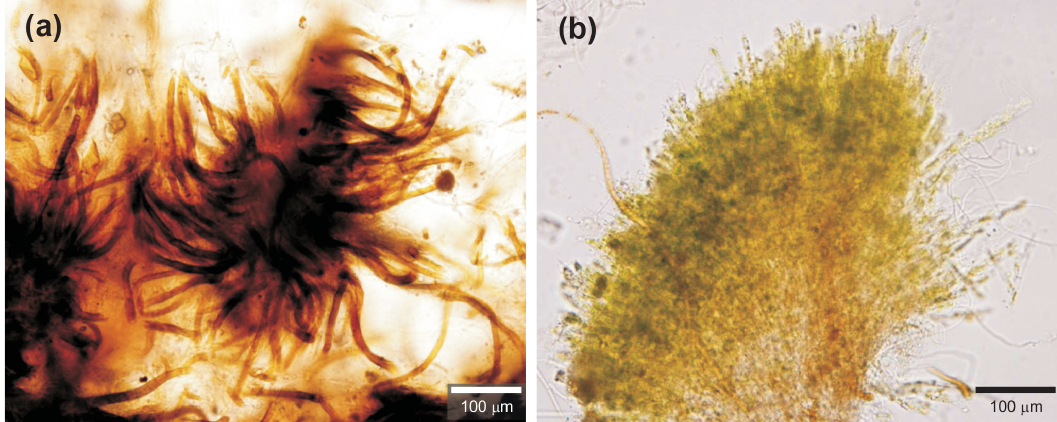
Figure 4. Dominant species in the photoautotrophic mats. (a) Calothrix elsteri , (b) Hazenia broadyi